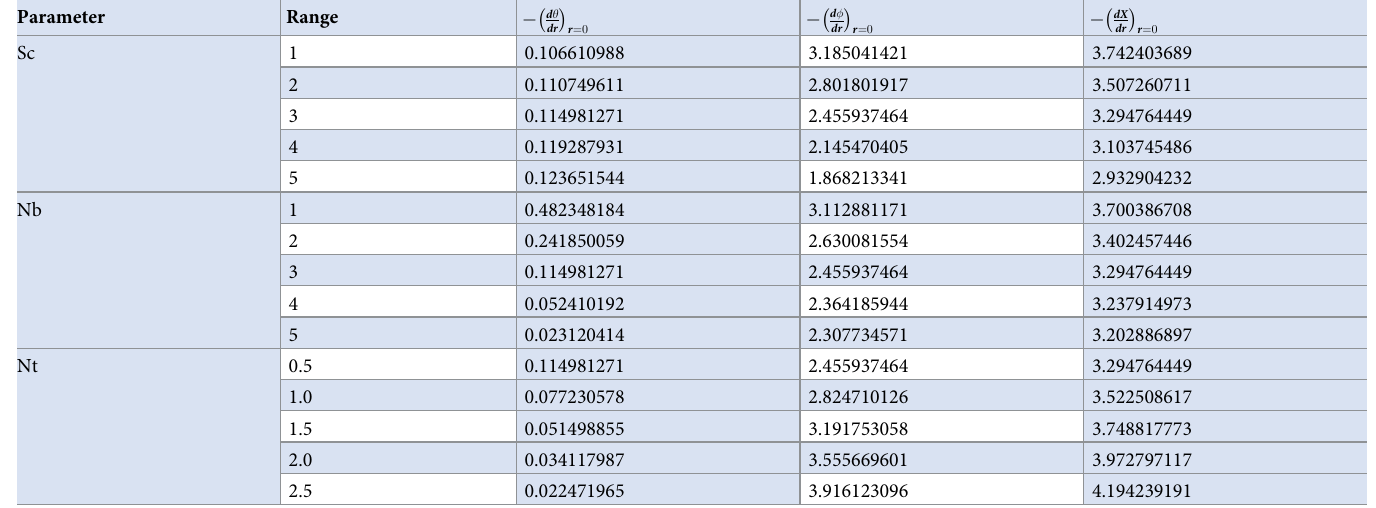
Table 2. Variations of quantities of physical interest for the changes in Sc , Nb and Nt . Parameter